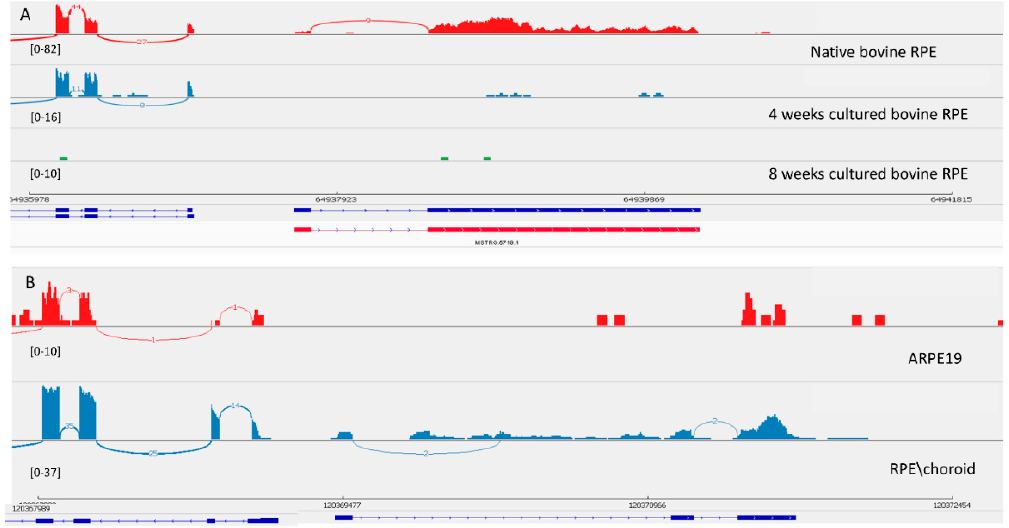
Figure 4. View of MSTRG.5719 from the Integrated Genome Viewer (IGV). IGV–Sashimi plots showing the read coverage and transcript isoforms. The histograms represent the sum of the aligned sequencing reads along the genome. Numbers in square brackets indicate coverage range. Junction reads are plotted as arcs, and the number of reads aligned to the junction spanning the exons connected by the arc is indicated. ( A ) Sashimi plots from bovine genome; red histogram represents the coverage for native bovine RPE, blue is 4-week cultured bovine RPE, and green is 8 weeks cultured bovine RPE. Below the histograms are shown the predicted isoforms (blue), experimentally verified in this study (red). ( B ) Sashimi plots from human genome; red histogram represents coverage for ARPE-19 cells and blue represents the native human RPE/choroid. Below the histograms are shown the Ensembl genome browser isoform (blue).